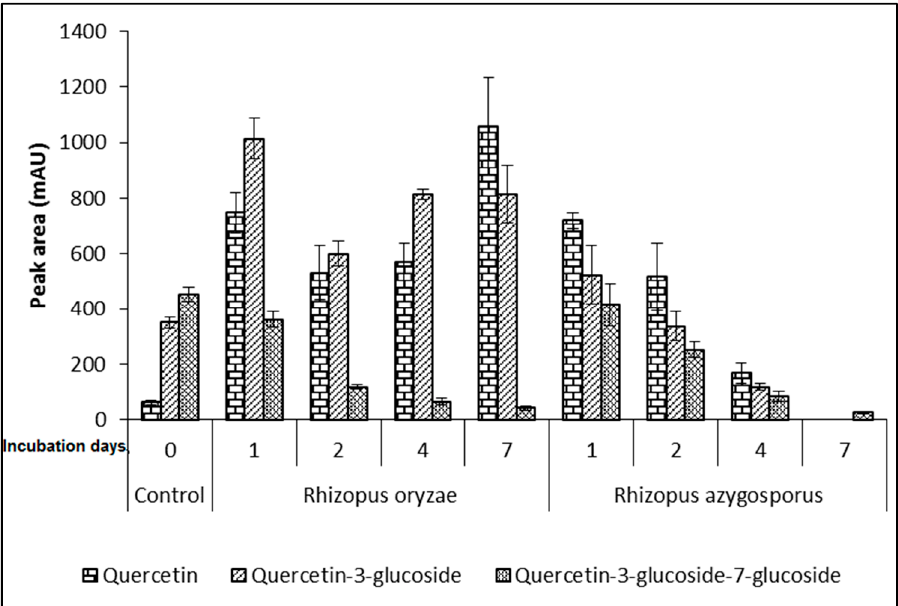
Figure 3. Accumulation of kaempferol, kaempferol-3-O-glucoside, kaempferol-3-diglucoside during 7 days of fermentation of cauliflower outer leave extracts ( n = 3).